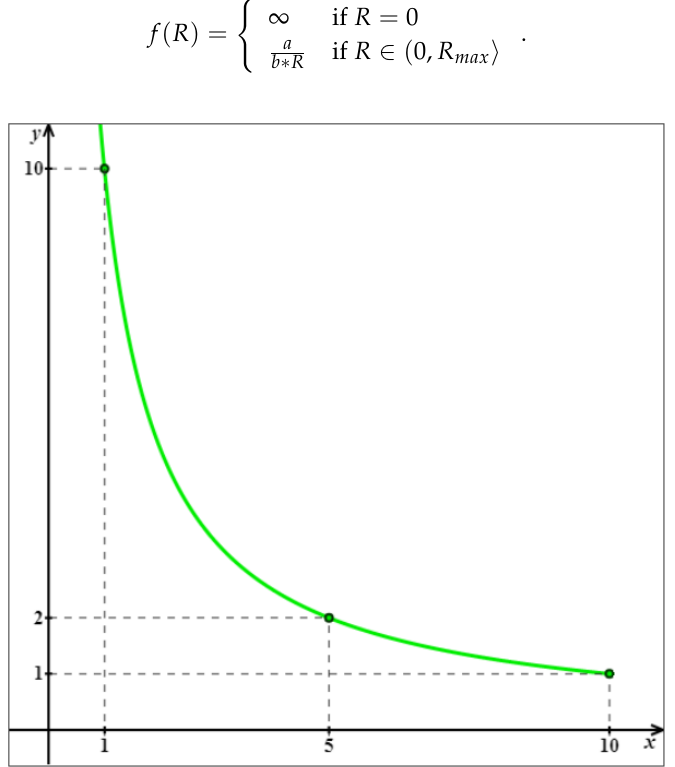
Figure 3. An example of the f ( R ) function, where R max = 10, a = 10 and b =